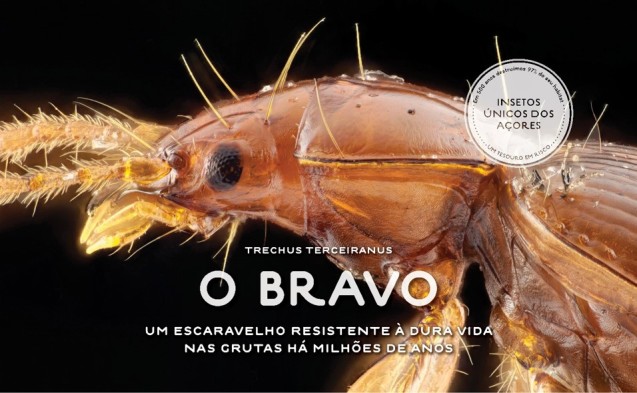
Trechus
terceiranus extreme macro photo used for an urban outreach initiative (Credit: Javier Torrent, Azorean Biodiversity Group, cE3c).